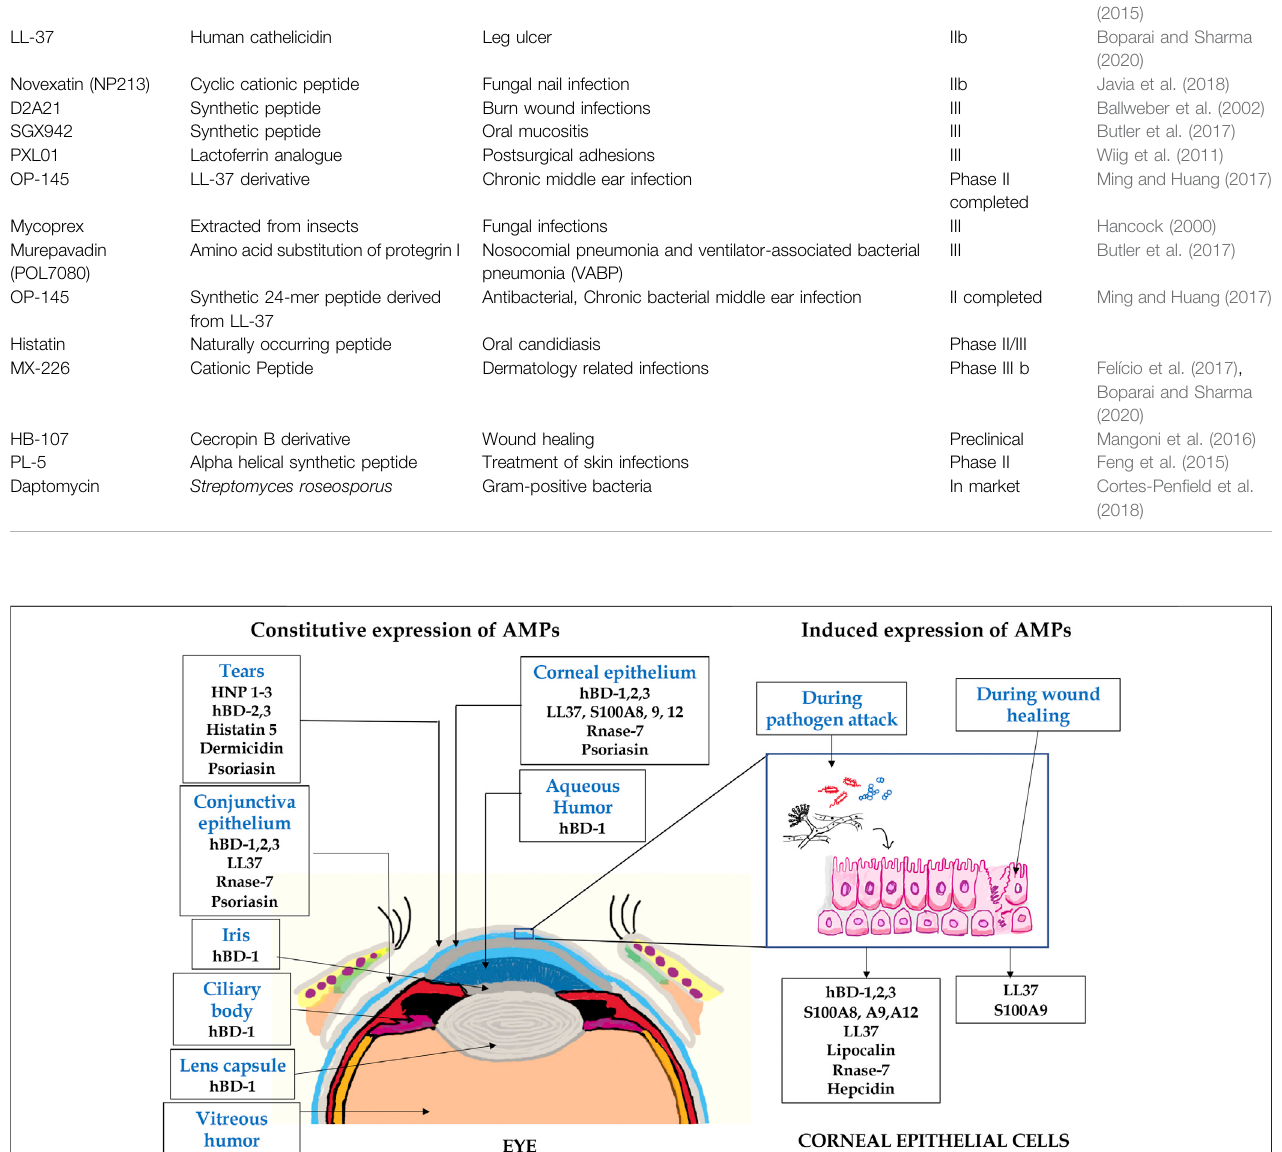
Frontiers in Chemistry |